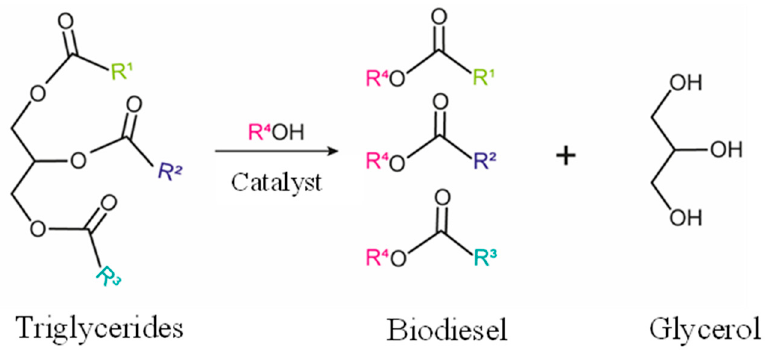
Figure 13. Transesterification of triglycerides for biodiesel production (R1, R2, R3 and R4 are alkyl groups).